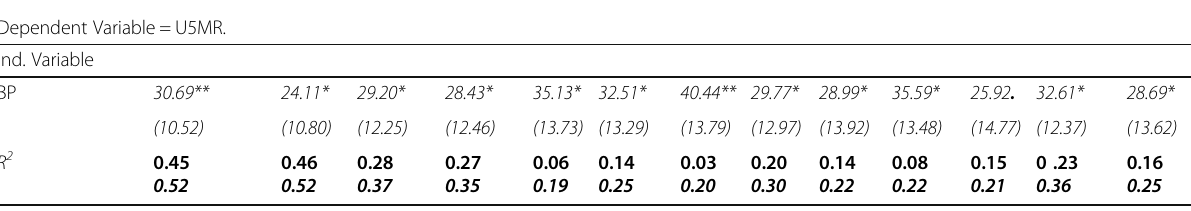
Table 4 Results for bivariate relationships between each IV and the DV (Continued) Dependent Variable =